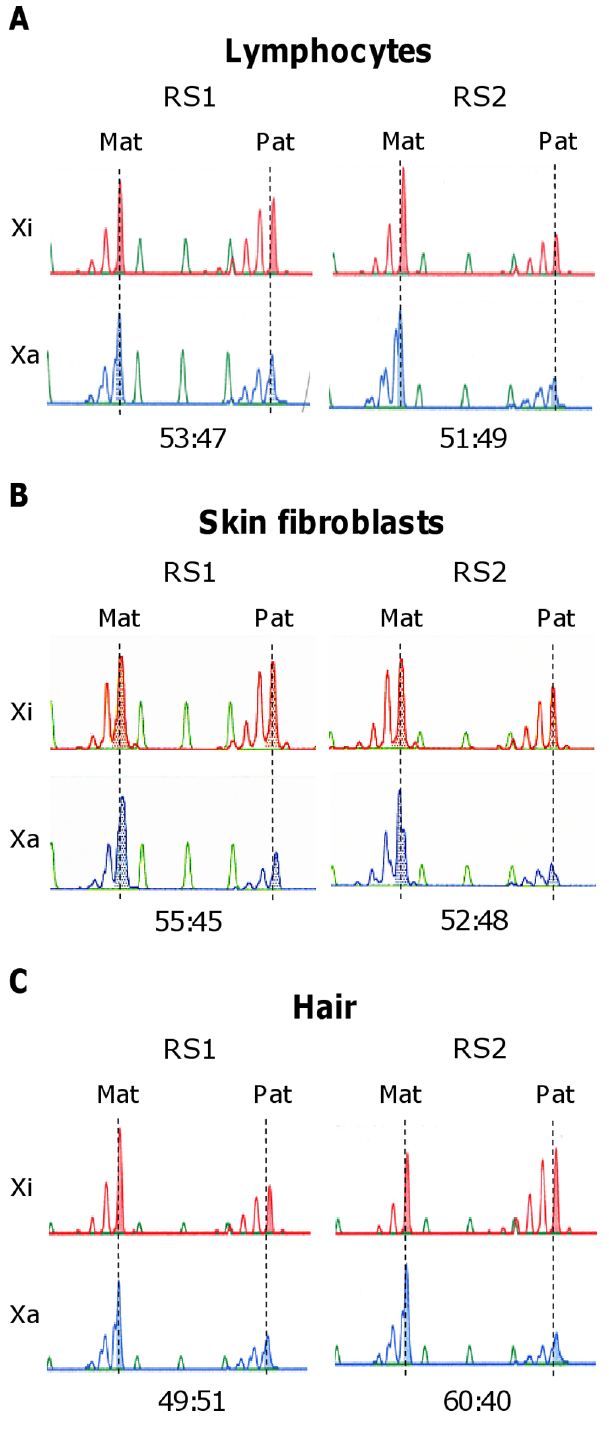
Figure 2. X chromosome inactivation analyses. Xi: X inactivation pattern based on the inactive X chromosome, Xa: X-inactivation pattern based on the active X chromosome. Mat: X chromosome inherited from the mother, Pat: X chromosome inherited from the father. Xi and Xa are differentiated by their methylation status at the androgen receptor gene locus. The maternal X and the paternal X are also differentiated by CAG repeat polymorphism at this locus. The X chromosome inactivation patterns showed no differences between the twins in lymphoblasts (A), skin fibroblasts (B), or hair cells (C).